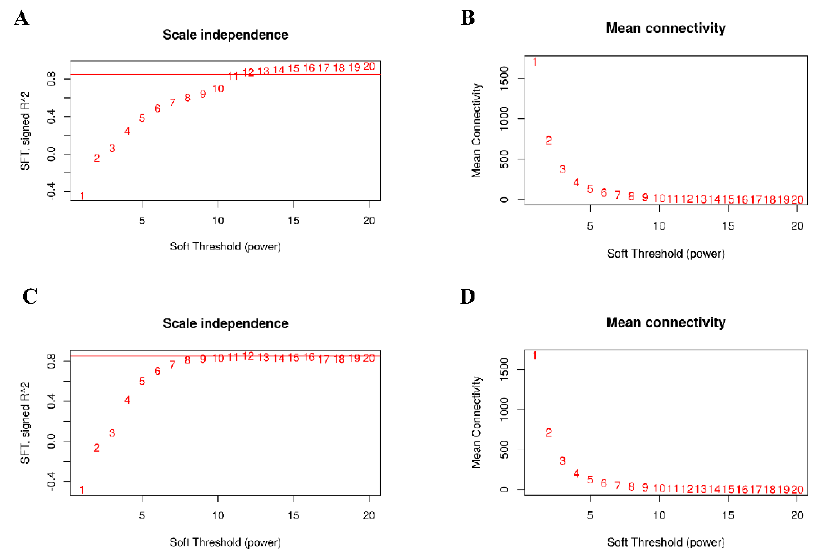
Figure 1. Network topology for different soft–thresholding powers of IR64 ( A , B ) and Koshihikari ( C , D ). The x -axis represents the weight parameter β . The y -axis of the left figure represents the square of the correlation coefficient between log(k) and log(p(k)) in the corresponding network. The y -axis of the right graph represents the mean of all gene adjacency functions in the corresponding gene module. The approximate scale free topology can be attained at the soft thresholding power of 12 in the two genotypes.